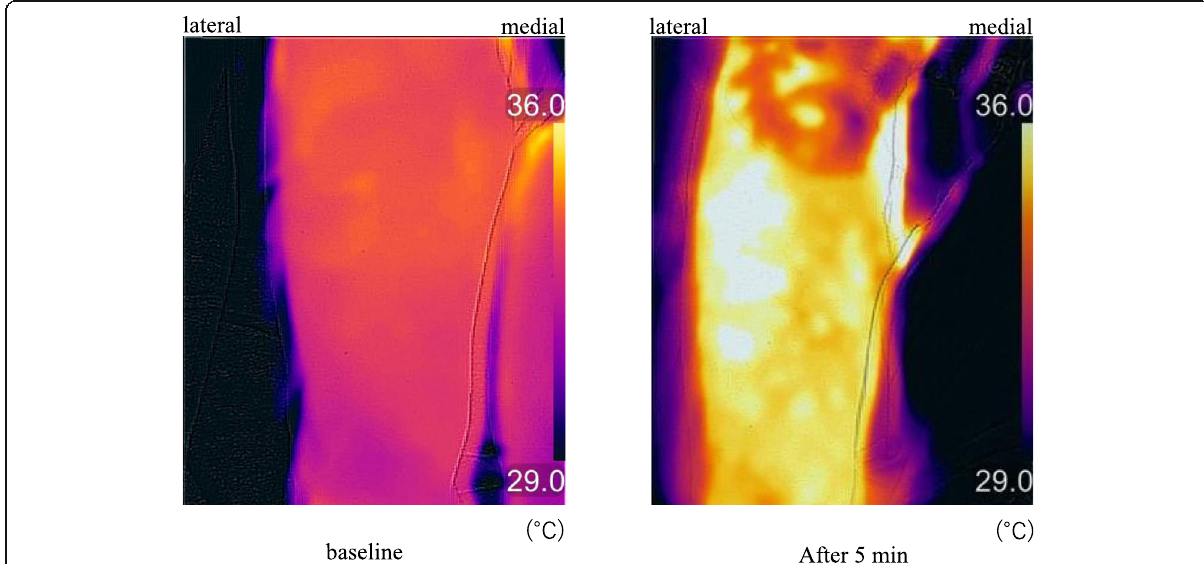
Fig. 2 Thermographic images acquired before and 5 min after ultrasound-guided supra-inguinal fascia iliaca block. Thermography predominantly in the lateral femoral nerve site in patient no. 1 resulted in an increase in skin temperature in the middle of lateral femoral site was increased from 33.6 to 35.8°C by nerve block